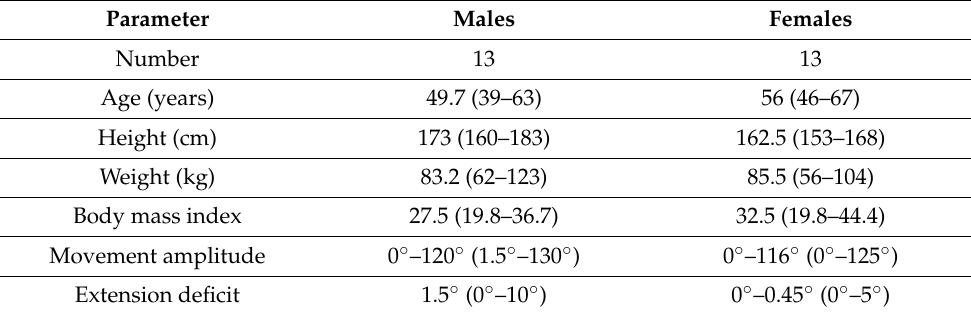
Table 1. Patient